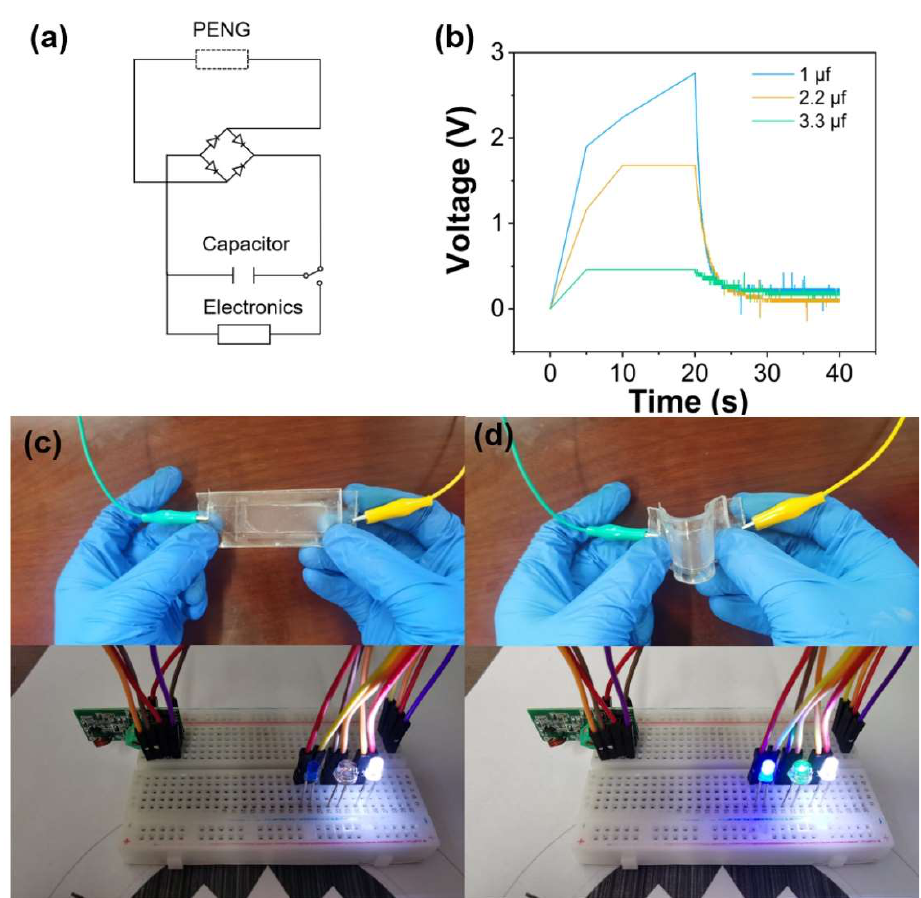
Figure 5. Feasibility of TSB-PENG as a power source. ( a ) Equivalent circuit of the self-charge system. ( b ) Charging voltage of different capacitor which is charged by TSB-PENG. ( c , d ) TSB-PENG drives Bluetooth device.